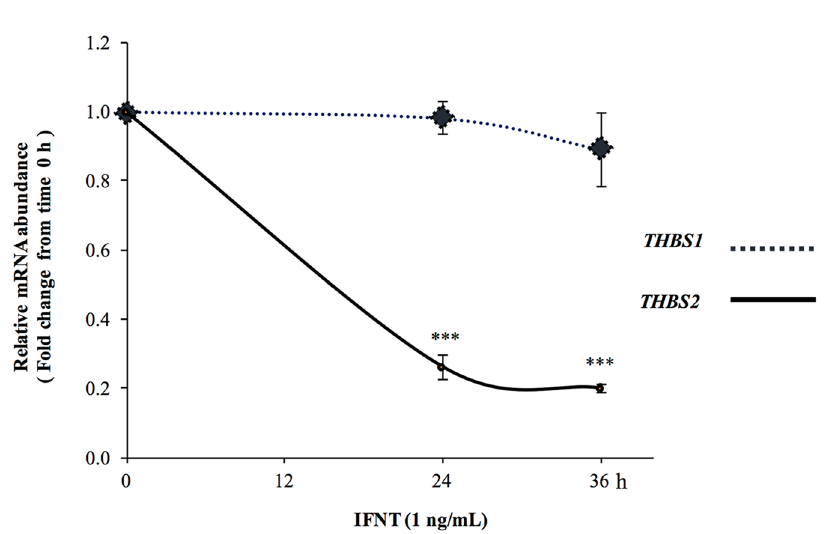
Figure 3. The effect of IFNT on THBSs mRNA in LGCS. Cells were incubated with roIFNT (1 ng/mL) for 24 and 36 h. Cells were then harvested, and the mRNA expression was determined using qPCR. Asterisks indicate significant differences from time 0 ( *** P <